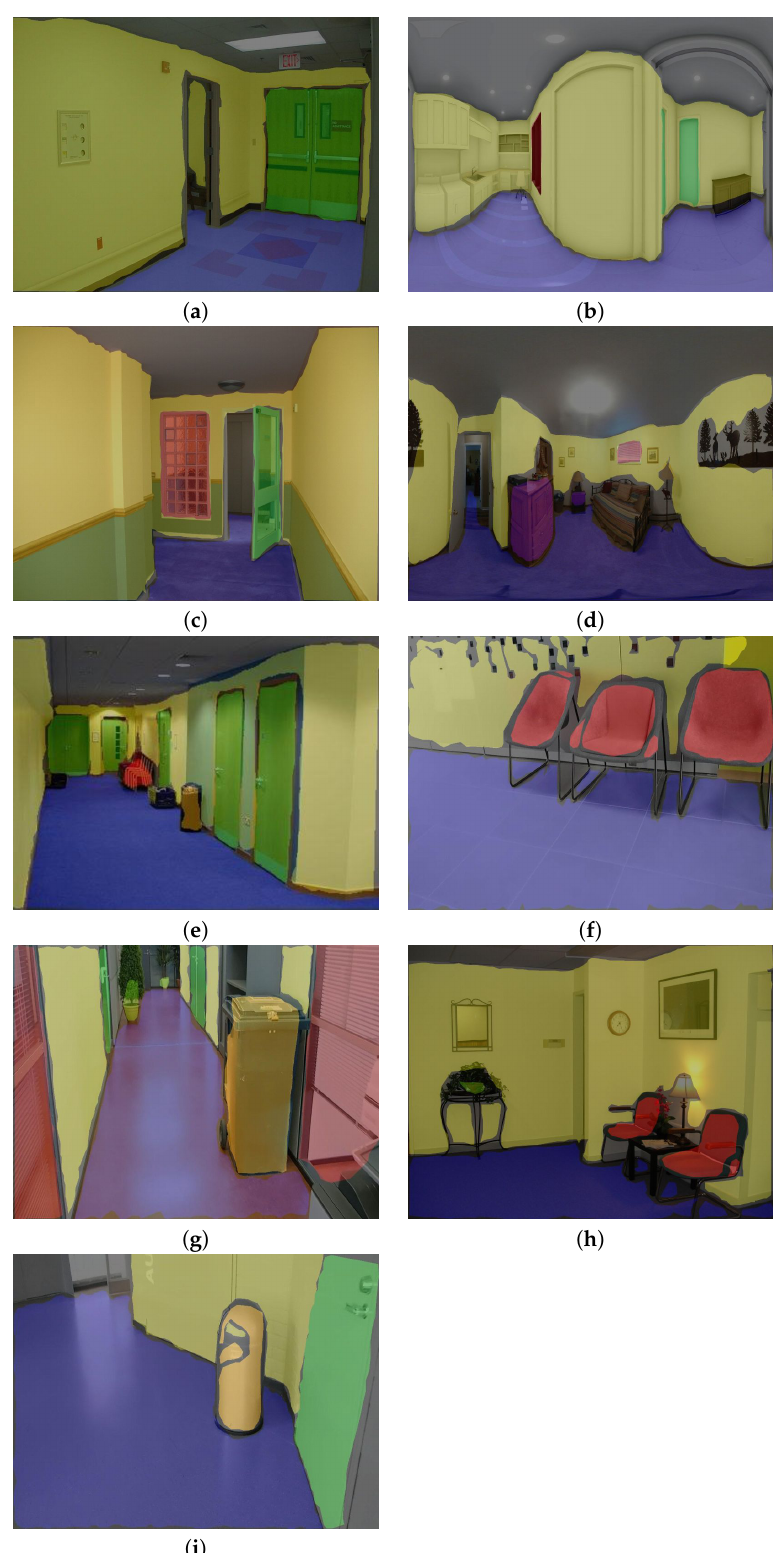
Figure 14. Offline experiment FCN8 segmentation